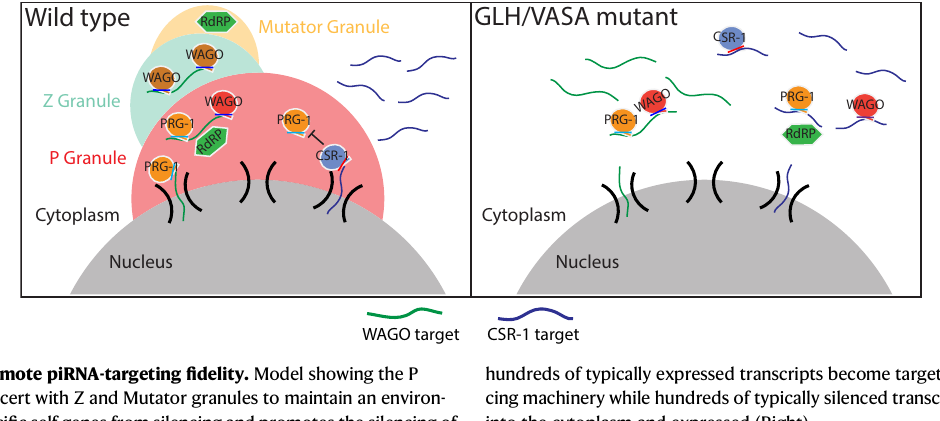
hundreds of typically expressed transcripts become targeted by PRG-1 and silen- cing machinery while hundreds of typically silenced transcripts become dispersed into the cytoplasm and expressed